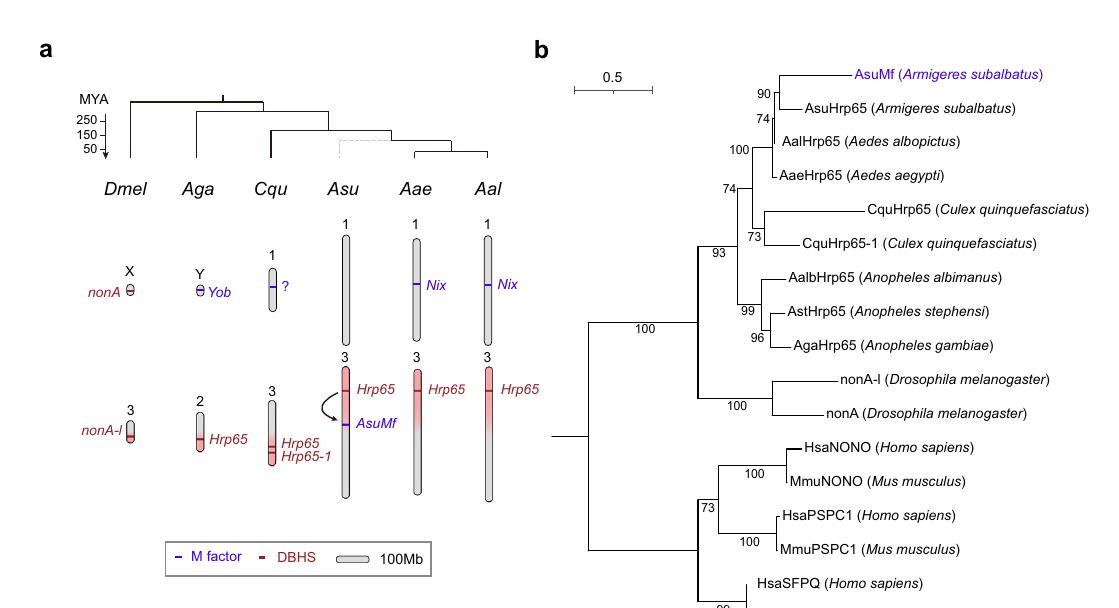
Fig. 3 | Ablation of AsuMf results in a transcription pro fi le shift from male to female for dsx , fru , and othergenes. a Left panel:sex-speci fi c alternative splicing of Asudsx and Asufru . Asudsx exon 6 and introns 6 and 7 are female-speci fi c. Asufru exon P1f is female-speci fi c. Numbers are the lengths in nucleotides of the exons. Right panel: Asudsx and Asufru alternative sex-speci fi c splice isoforms were con- fi rmed by gene ampli fi cation with primers (F and R) that span the sex-speci fi c alternativeregions. Asudsx hasthreefemale-speci fi cisoformsandonemale-speci fi c isoform. Asufru has one female- and male-speci fi c isoform each. The sequences of sex-speci fi c alternative splice isoforms are shown in SupplementaryText2. Similar results were obtained in three independent experiments. b The relative abundan- ciesoffemaleandmaleisoformsof Asudsx and Asufru weredeterminedbyqPCRin